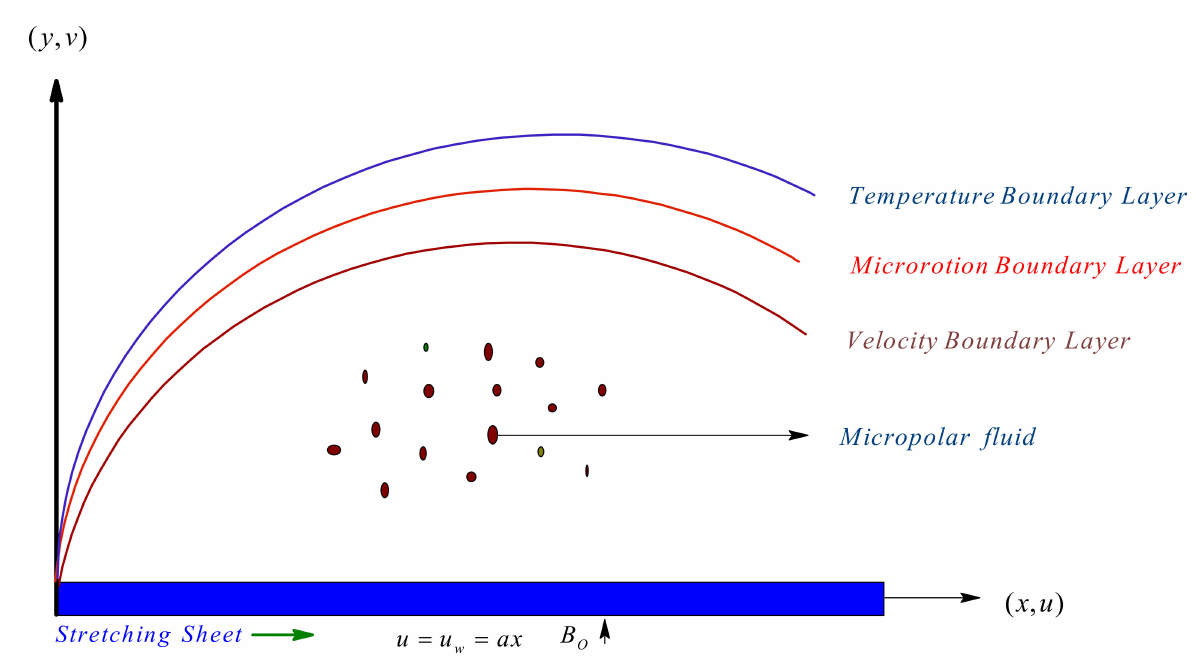
Figure 1. Physical flow